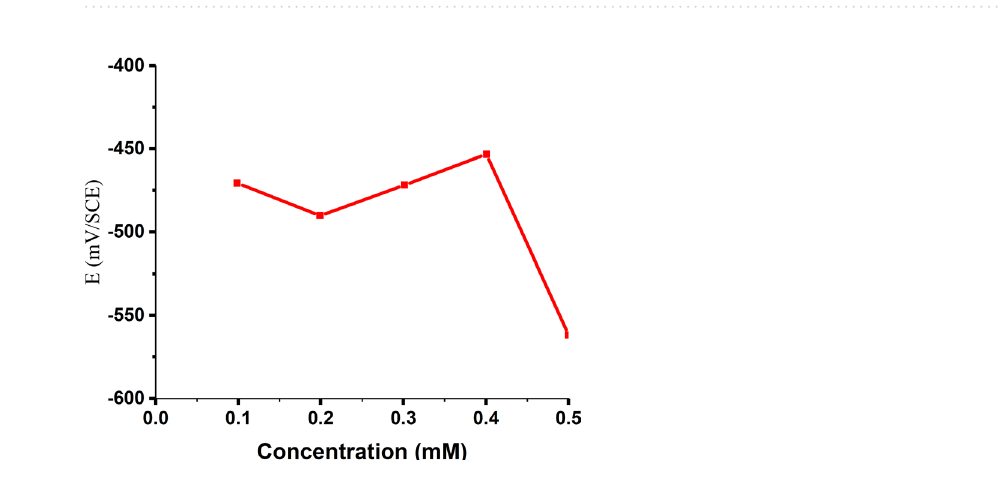
Figure 7. OCP as a function of the nonanedihydrazide concentration for MS in 1.0 M HCl at 303